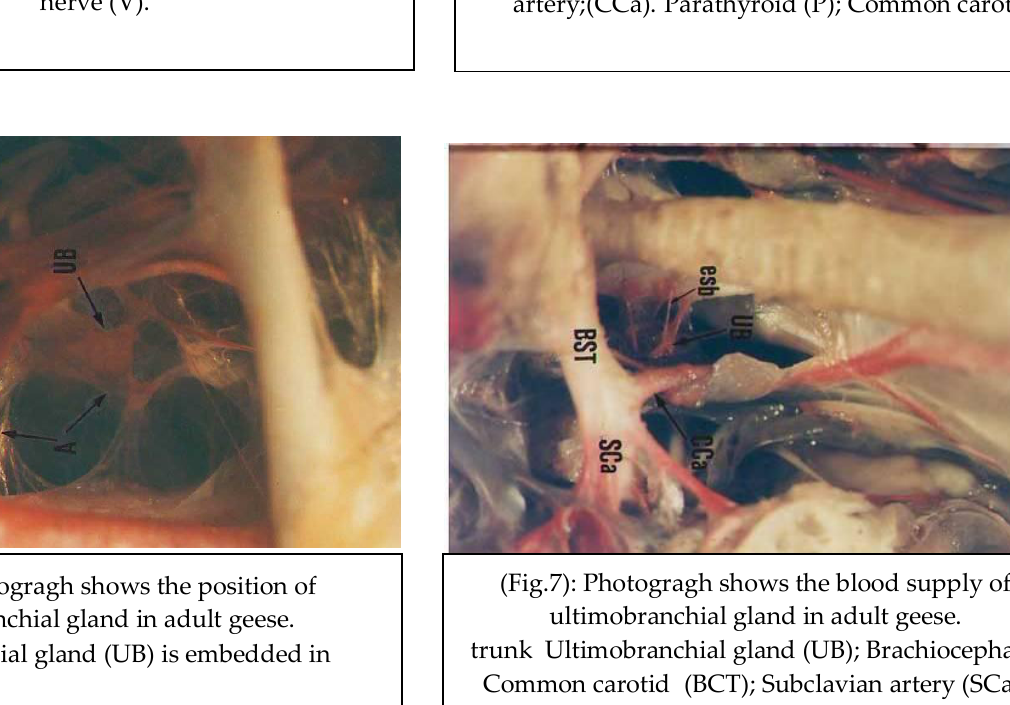
(Fig.4): Photogragh shows the position of ultimobranchial gland in adult geese. Ultimobranchial gland (UB); Esophagus (es); Jugular vein (J); Vagus nerve